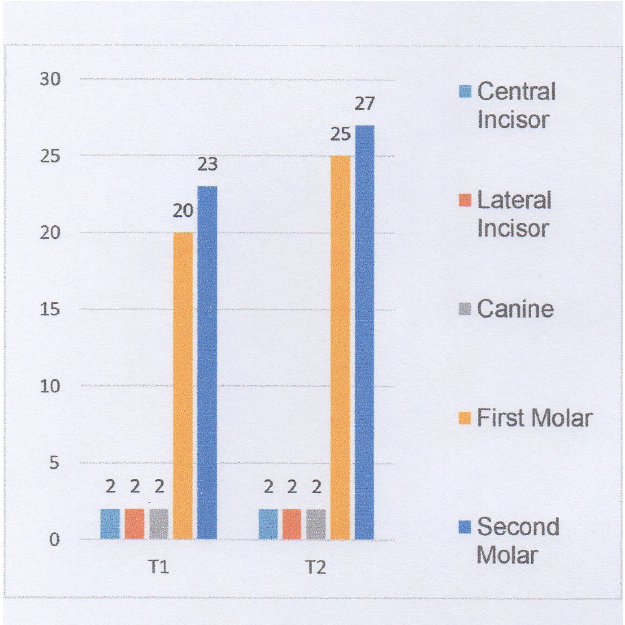
Fig. 2 - Lower deciduous teeth with caries lesions. Parnaíba-PI.